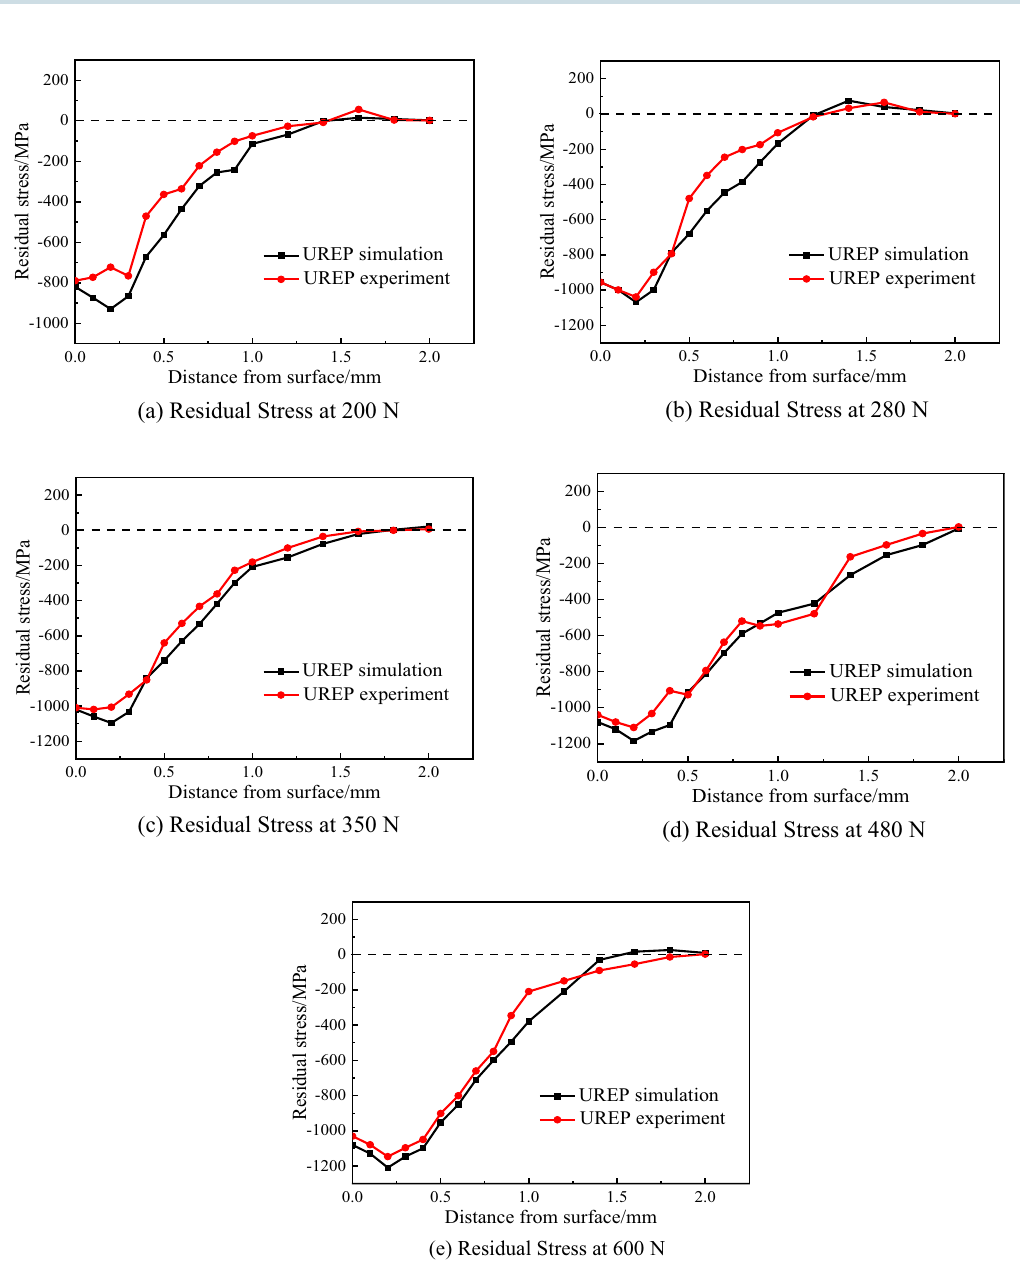
Figure 8. Residual stress of UREP at different static